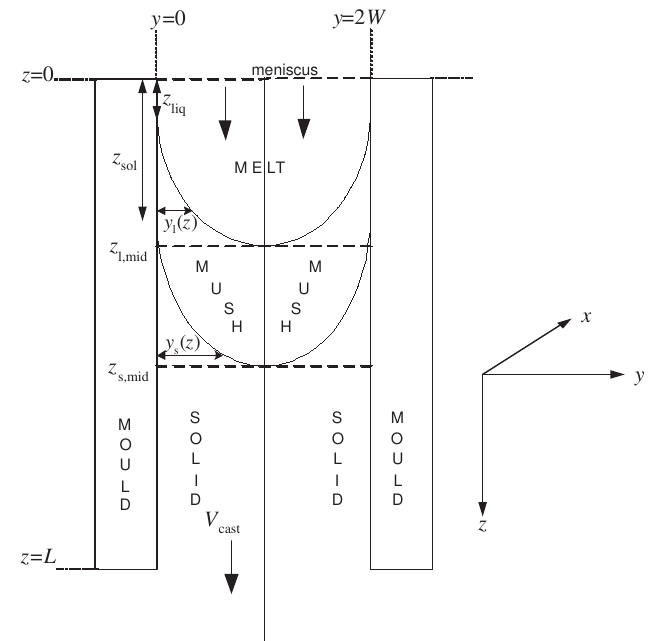
Figure 4. 2D schematic of the vertical continuous casting of an alloy.